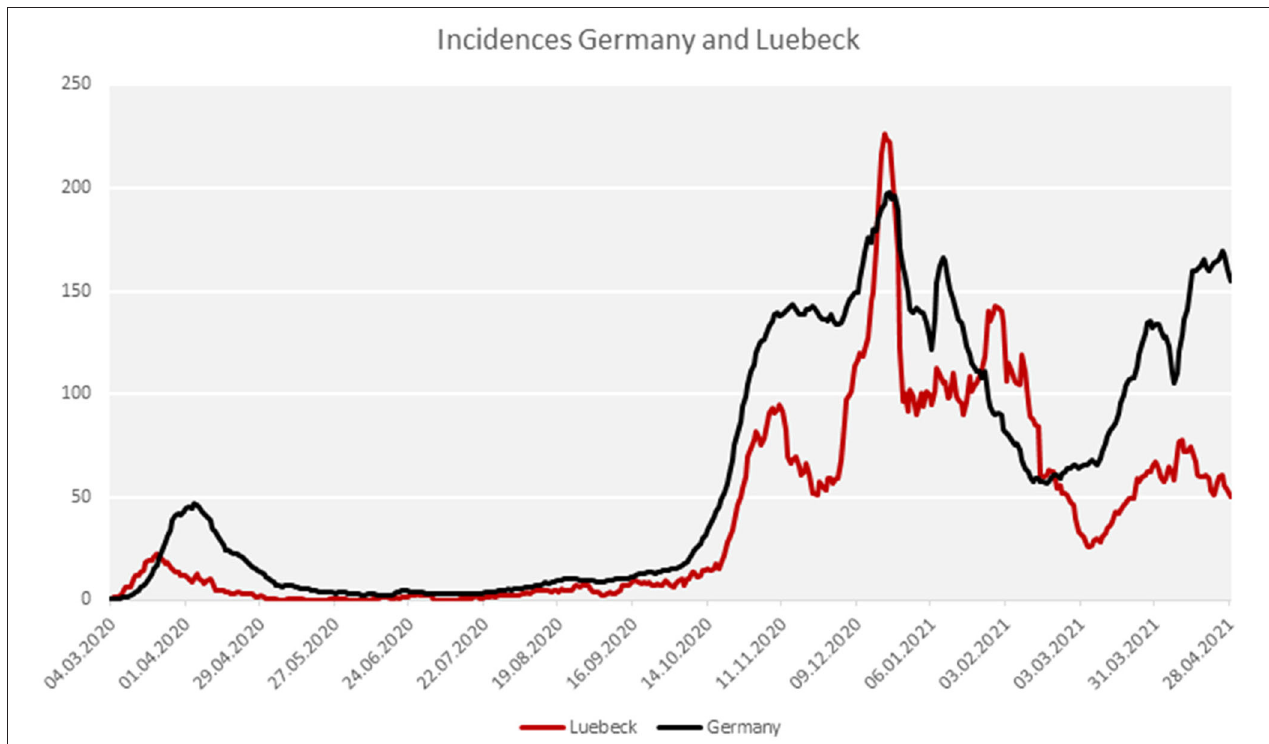
FIGURE 1 | COVID-19 incidence in the city of Luebeck in comparison to